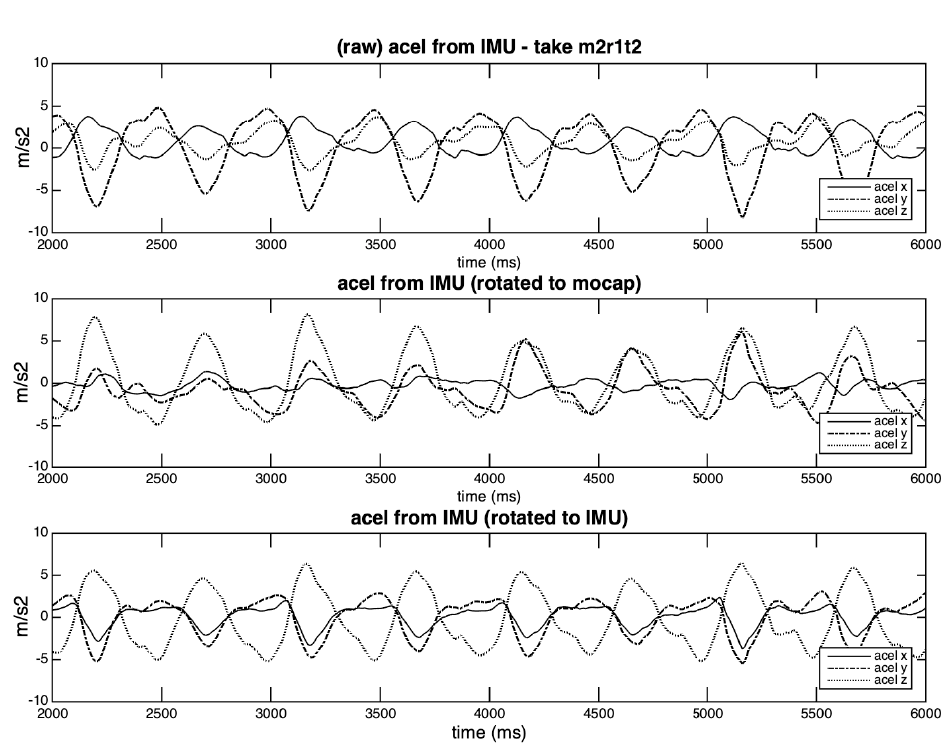
Figure 18. Accelerations curves from take m2r1t2: original, rotated to Qualisys angles, IMU-rotated. Table 7. Covariances between displacement magnitude of each system with two different rotation matrices and two integration methods—musicians 1 and 2. Take Mocap-Rotated IMU-Rotated (s. lobe) (w. lobe) (s. lobe) (w. lobe)